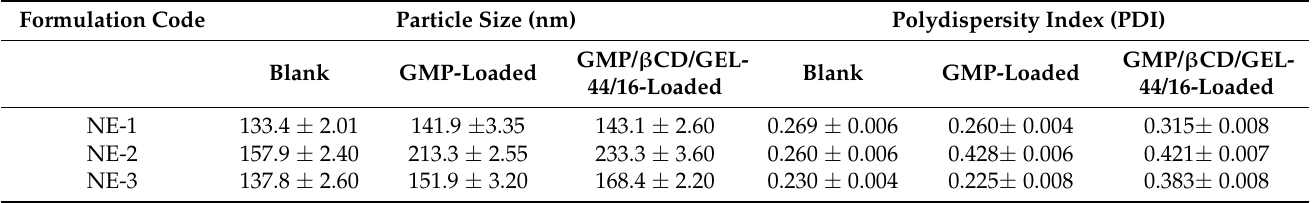
Table 2. Particle size, polydispersity index (PDI) of blank (B), glimepiride-loaded (GMP), and inclusion complex-loaded (IC) nanoemulsions (Mean ± SD, n = 3).